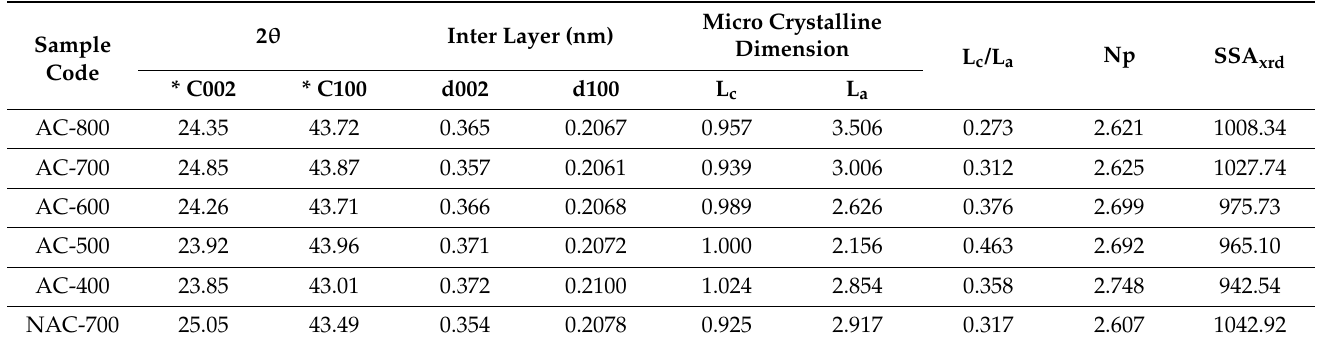
Table 1. Interlayer d-spacing and microcrystalline dimensions of carbon material at various tempera- tures. (* is corresponding to the XRD major peak).